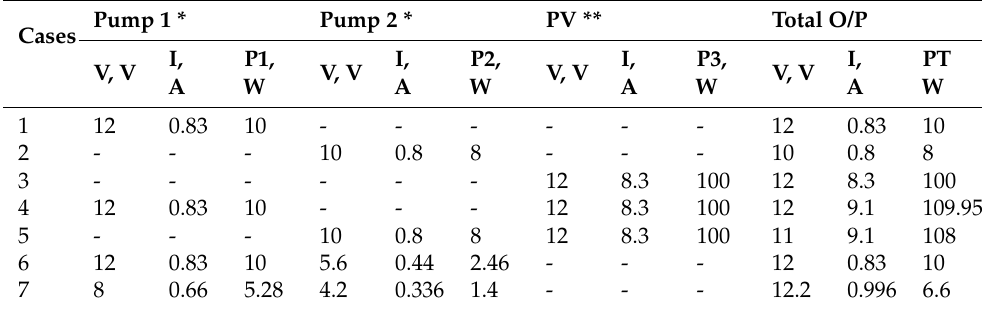
Table 10. Different output values from three-generation systems. Pump 1 Cases